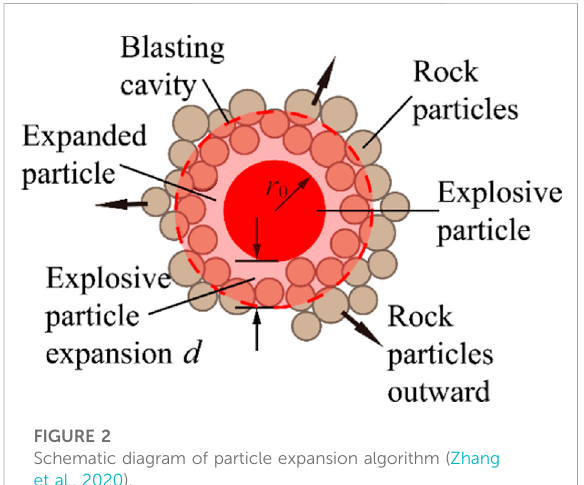
FIGURE 2 Schematic diagram of particle expansion algorithm (Zhang et al., 2020).